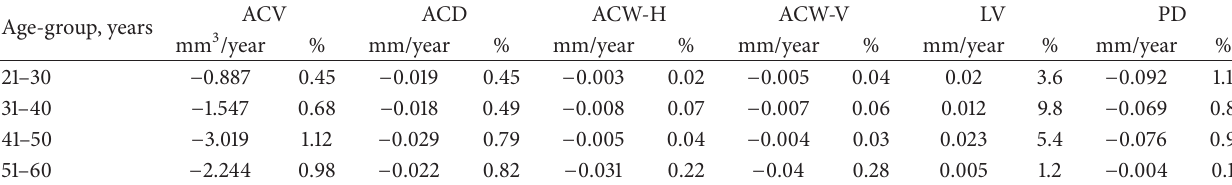
Table 5: Annual reductions in anterior segment parameters according to the age of subjects.